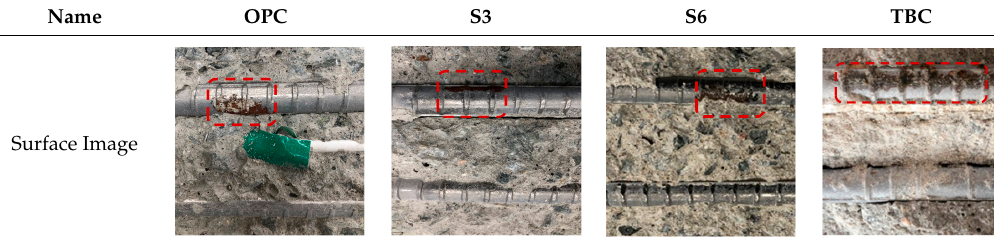
Table 7. Surface image of rebar after OCP monitoring experiment.